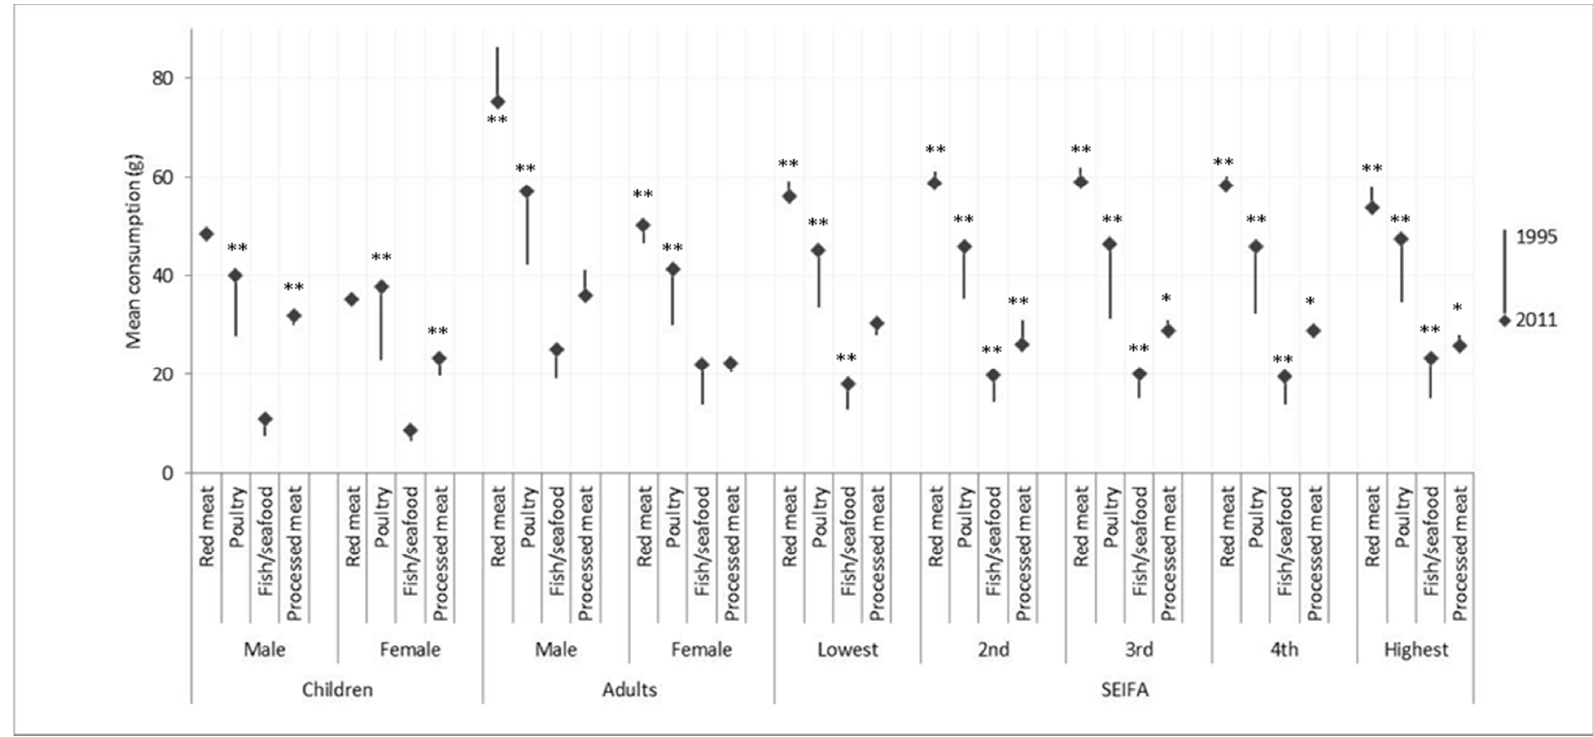
Figure 1. Per-capita mean consumption (g) of meat/poultry/fish from 1995 to 2011–2012, in children and adults, separated by gender, and SEIFA category. * p -value < 0.05 from Mann–Whitney U test; ** p -value < 0.01 from Mann–Whitney U test; — (cid:7) The start of the arrow indicates the per-capita consumption of meat/poultry/fish at 1995; the end of the arrow (capped by a square) indicates the per-capita consumption of meat/poultry/fish at 2011; the length of the arrow indicates the change of the per-capita consumption of meat/poultry/fish from 1995 to 2011–2012.